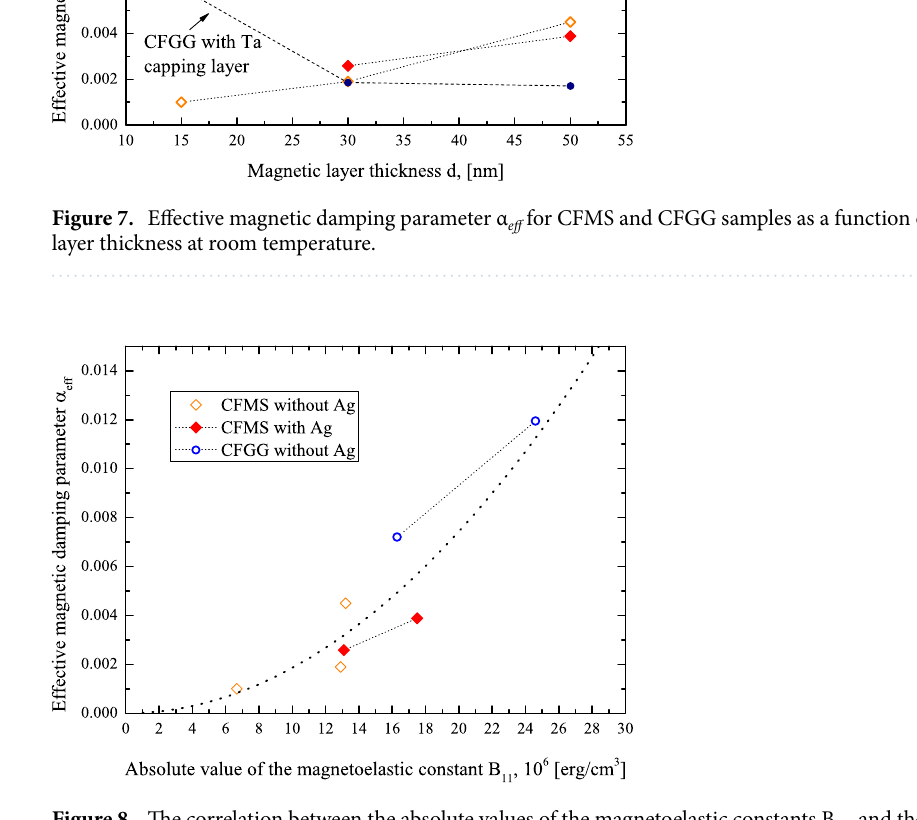
Figure 8. The correlation between the absolute values of the magnetoelastic constants B 11 , and the effective magnetic damping parameter α eff for the three series of the samples, for which the influence of the spin pumping on the magnetic damping can be neglected. Dashed line shows the fit using quadratic